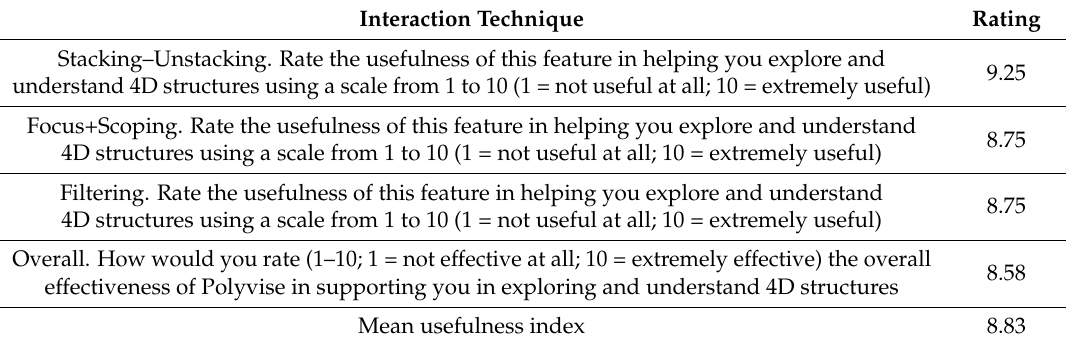
Table 2. Participants’ assessment of the overall usefulness of each interaction technique in